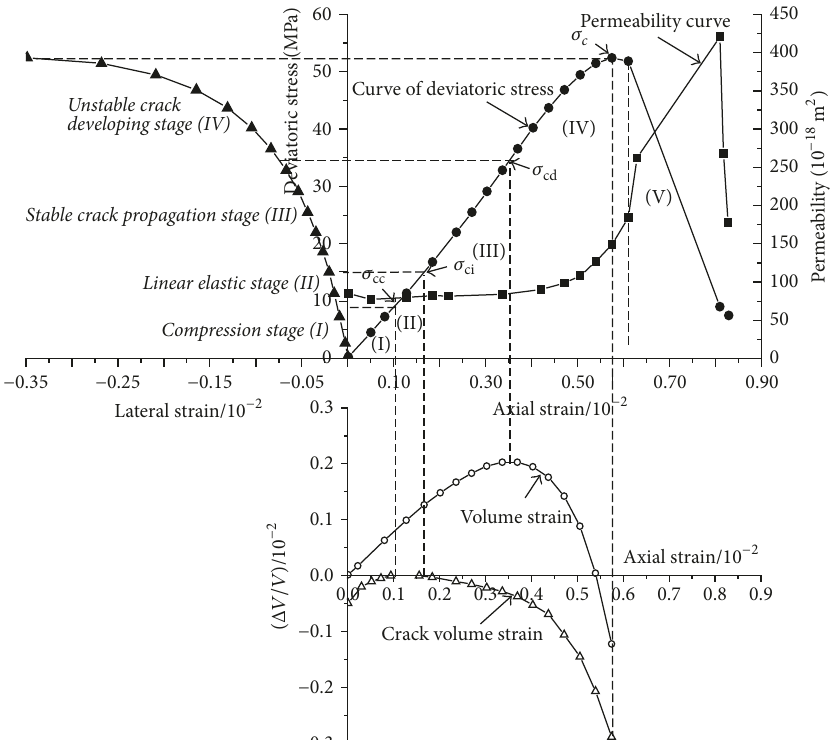
Figure 3: Curves of different strain versus deviatoric